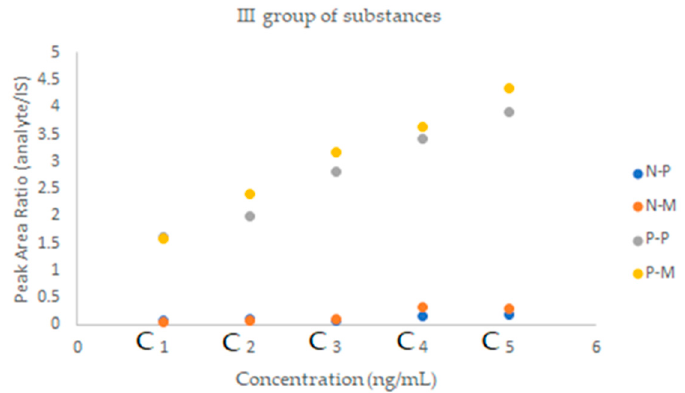
Figure 5. A graphical representation of the matrix effect between two parallel calibration curves for the II group substances, prepared without and with the matrix. P—samples without the matrix, M—samples with the matrix; *—value multiplied by hundred (for better visibility).